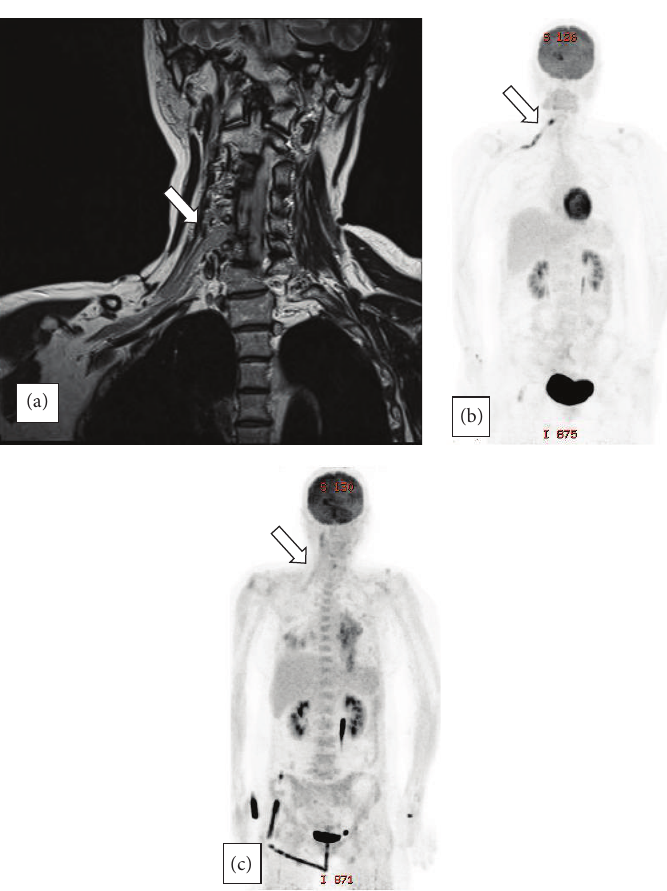
Figure 2: (a) Cervical spine MRI (T2-weighted image). Cervical spine MRI demonstrated a 0.7 × 0.9 cm sized mass (white arrows) in the extraforaminal portion of C5 and C6, with T2 high signal intensity. Nerve roots of C5 and C6 were compressed by the mass, but there was no involvement of the spinal canal or epidural space and bone. These features were not found on the cervical MRI performed 5 months ago. (b) PET-CT. Strong linear FDG uptake along the right brachial plexus and strong focal FDG uptake in the extraforaminal portion of C5 and C6 was seen. (c) Follow-up PET-CT. There was no abnormal FDG uptake in the previous right brachial lesion after